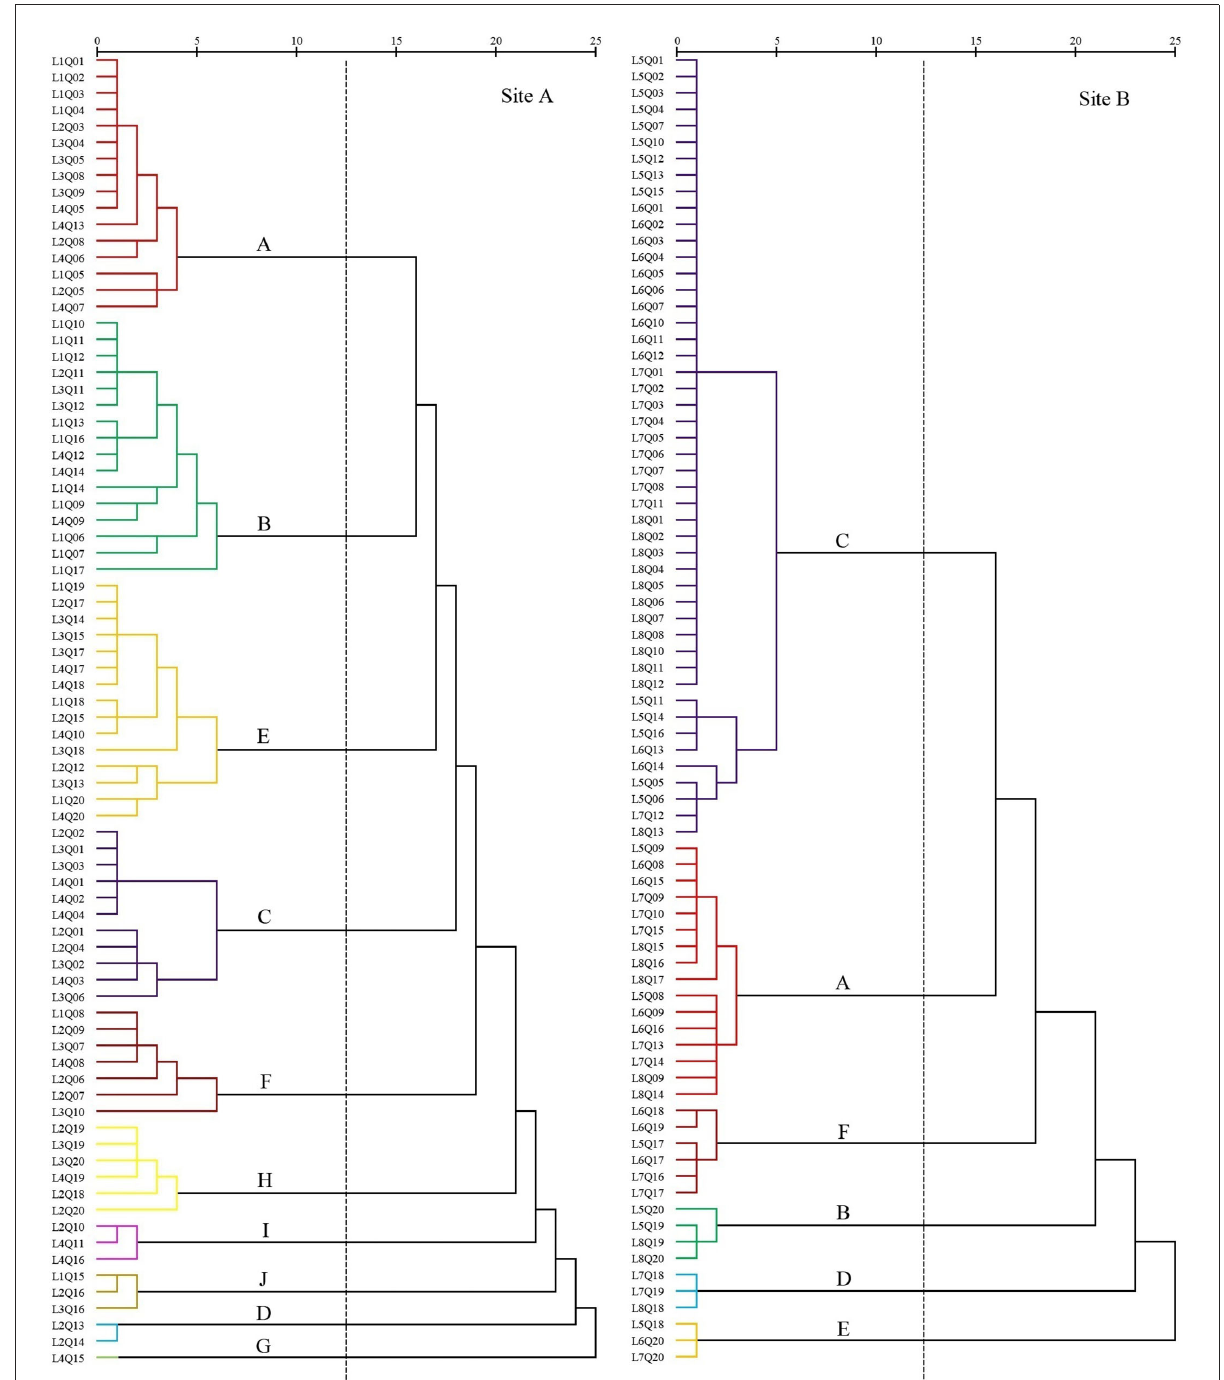
FIGURE4 Dendrogram of coastal wetland vegetation based on cluster analysis of data collected in 2018.